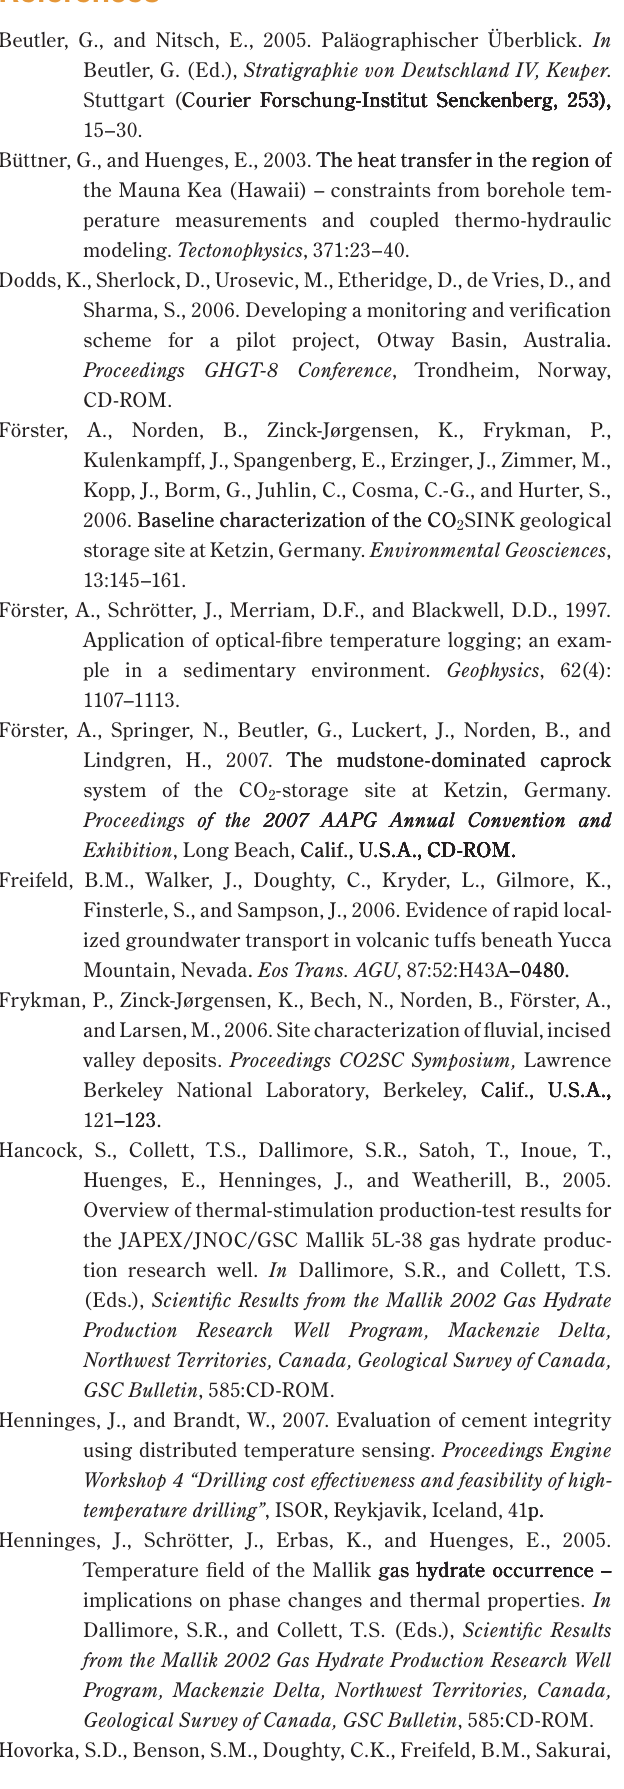
Fig. 1. VNG - Verbundnetz Gas AG, Leipzig, Germany. 1. VNG - Verbundnetz Gas AG, Leipzig, Germany 1. VNG - Verbundnetz Gas AG, Leipzig, Germany. VNG - Verbundnetz Gas AG, Leipzig, Germany VNG - Verbundnetz Gas AG, Leipzig, GermanyVerbundnetz Gas AG, Leipzig, Germany Fig. 5. Silvio Mielitz, GeoForschungsZentrum Potsdam,. 5. Silvio Mielitz, GeoForschungsZentrum Potsdam, 5. Silvio Mielitz, GeoForschungsZentrum Potsdam,. Silvio Mielitz, GeoForschungsZentrum Potsdam, Silvio Mielitz, GeoForschungsZentrum Potsdam,Silvio Mielitz, GeoForschungsZentrum